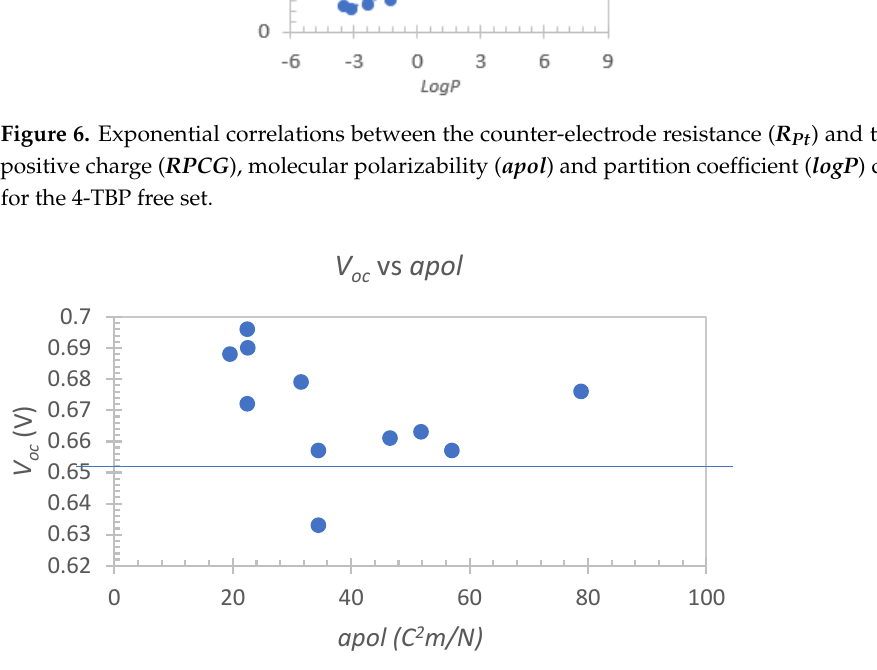
Figure 6. Exponential correlations between the counter-electrode resistance ( R Pt ) and the relative positive charge ( RPCG ), molecular polarizability ( apol ) and partition coefficient ( logP ) descriptors for the 4-TBP free set.